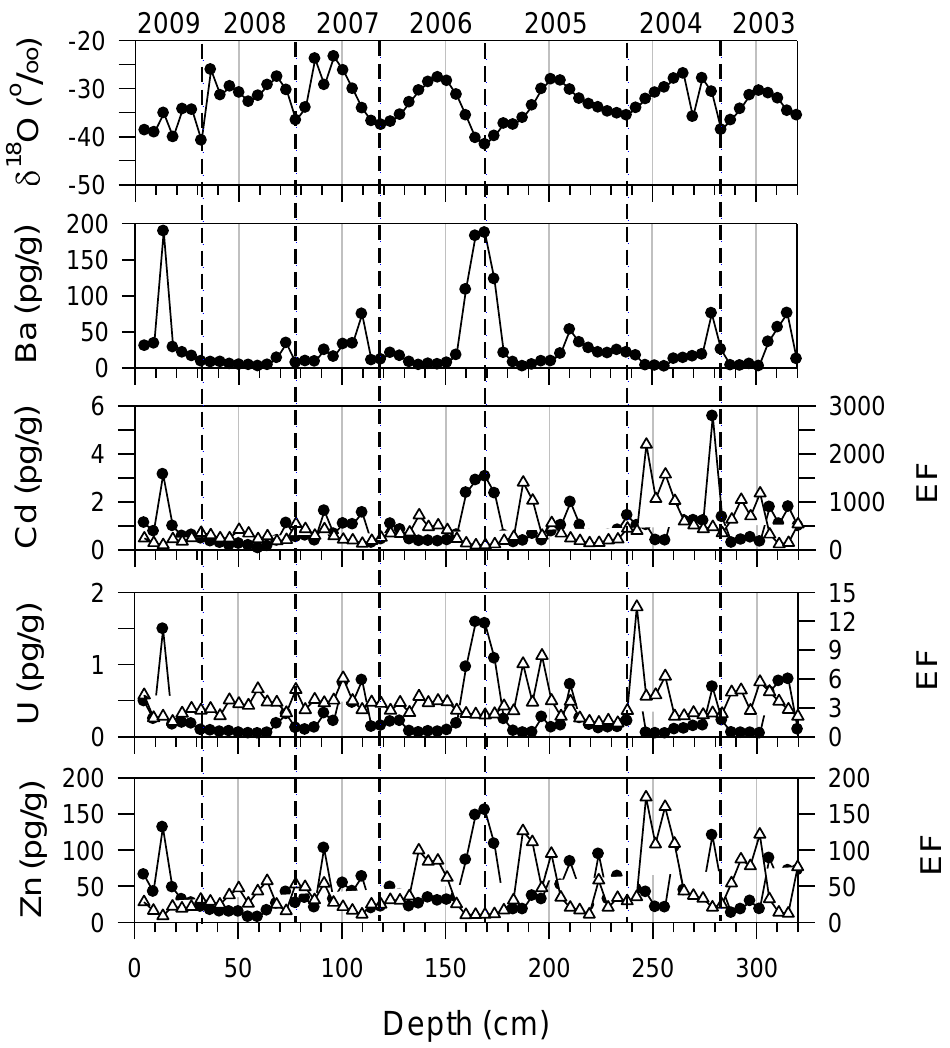
Figure 1. Depth profiles of δ 18 O, Ba, Cd, U, and Zn concentrations (solid circles) and crustal enrichment factors (EF) (open triangles) determined in the NEEM snow pit samples in Greenland. Vertical dashed lines represent the minima of δ 18 O in winter during the period